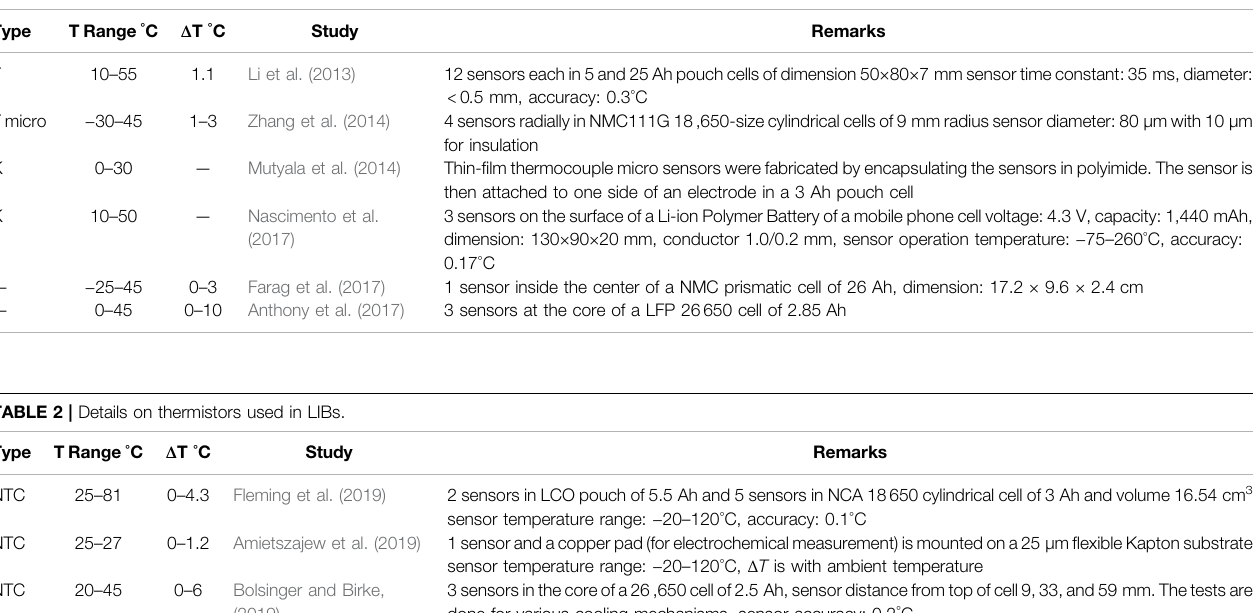
TABLE 1 | Details on thermocouple sensors used in LIBs.